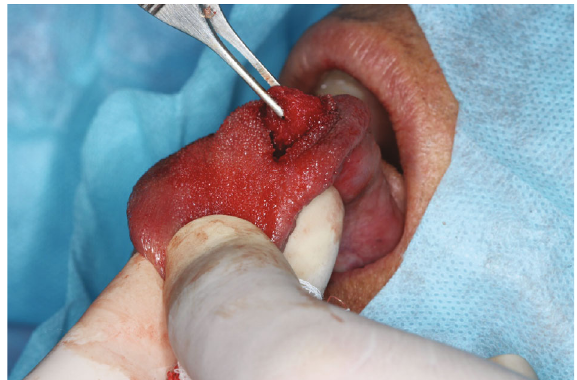
Figure 4: Divulsion of the lesion, using blunt-tip instruments, from the adjacent tissue planes, having been cleaved without the rupture of its evident lining